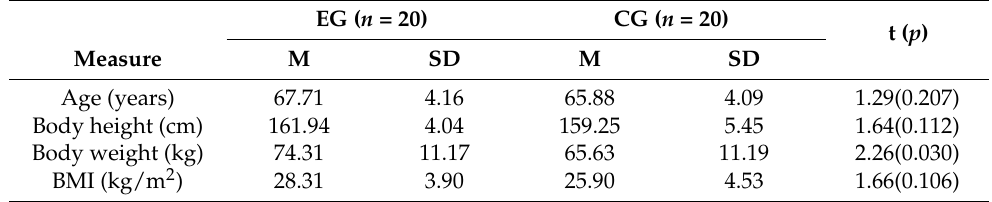
Table 1. Mean values, standard deviations and results of between-group comparison (t-test for independent samples) for basic characteristics of participants prior to the start of the experiment.